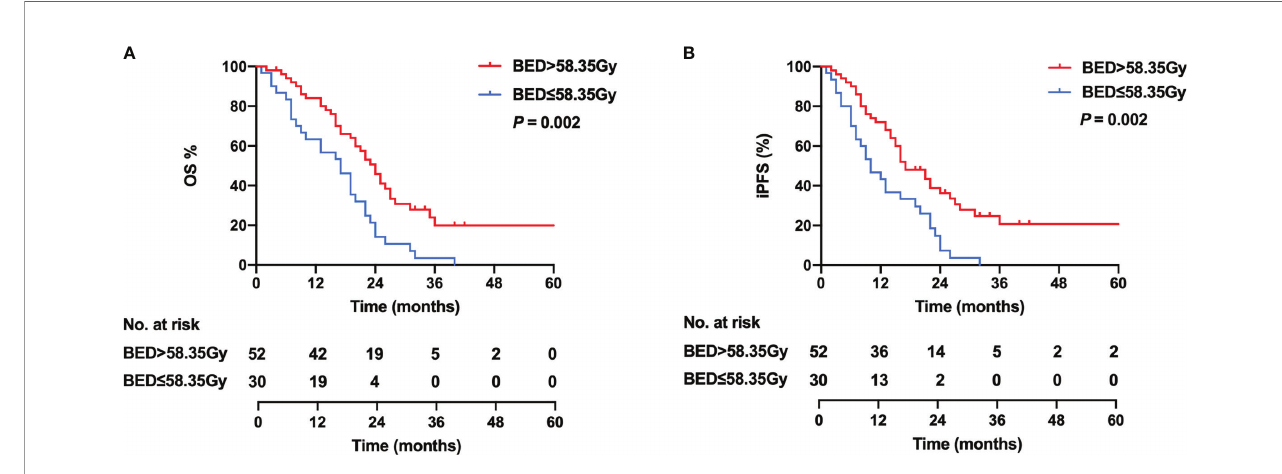
FIGURE 5 | Kaplan – Meier curves for OS (A) and iPFS (B) in the high-BED group (BED > 58.35 Gy) and the low-BED group (BED ≤ 58.35